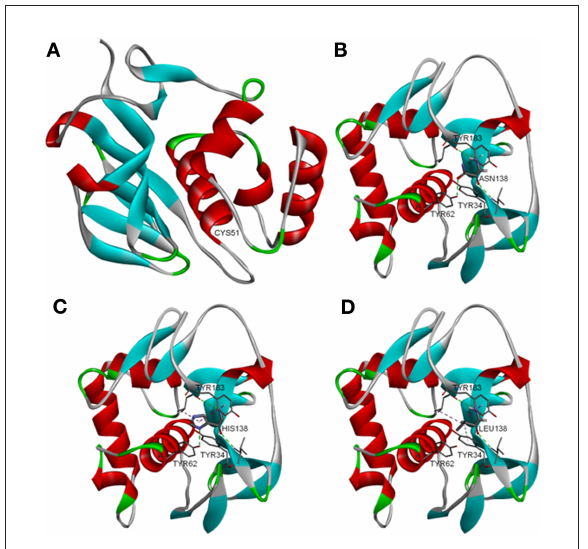
FIGURE1 Molecular modeling of L pro . Structural analysis of L pro reveals an aromatic pocket located opposite from the substrate binding domain. (A) This pocket consists of three tyrosines coordinated by an internal histidine residue (H138), which is absolutely conserved across serotypes. Simulations were performed to assess the effects of different point mutations replacing the histidine at position 138. (B–D) Incorporation of different mutations selectively preserved or disrupted different components of the interaction. Simulations were used to generate a collection of mutants with varying degrees of functional